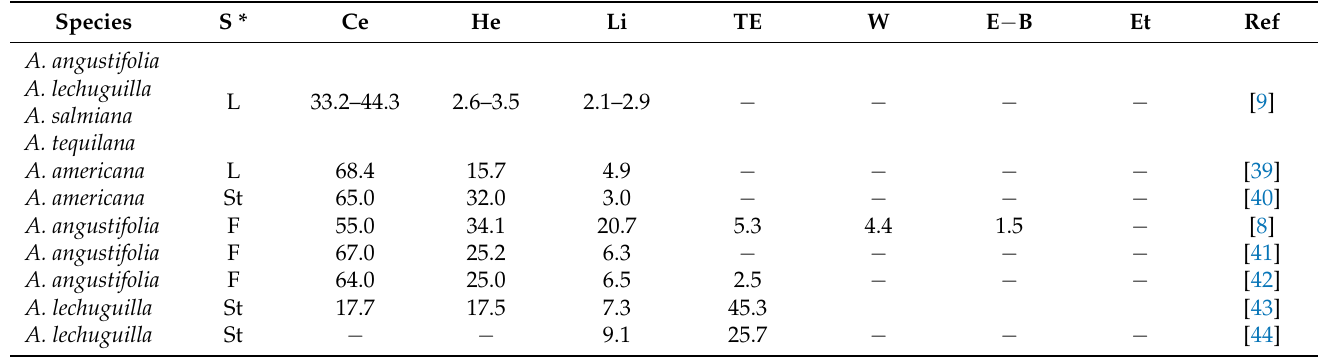
Table 9. Percentages of extractives and lignocellulosic compounds of Agave , Furcraea , and